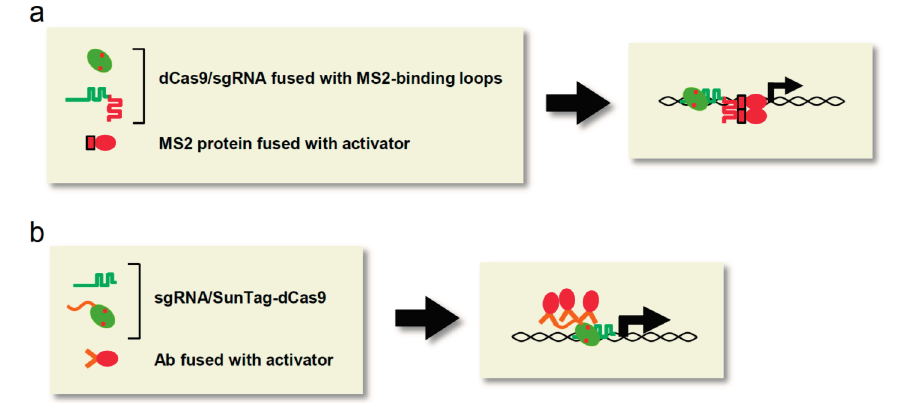
Figure 2. CRISPR/Cas-specific applications to transcriptional regulation. ( a ) Scaffold RNA system. Desired proteins such as transcriptional activators can be recruited to target loci via interaction with the modified sgRNA. MS2 protein: red rectangle: MS2-binding loop: red line; ( b ) The SunTag system. Desired proteins such as transcriptional activators can be recruited to target loci via interaction with the SunTag-fused dCas9. SunTag: orange line fused with dCas9; Ab: two orange straight